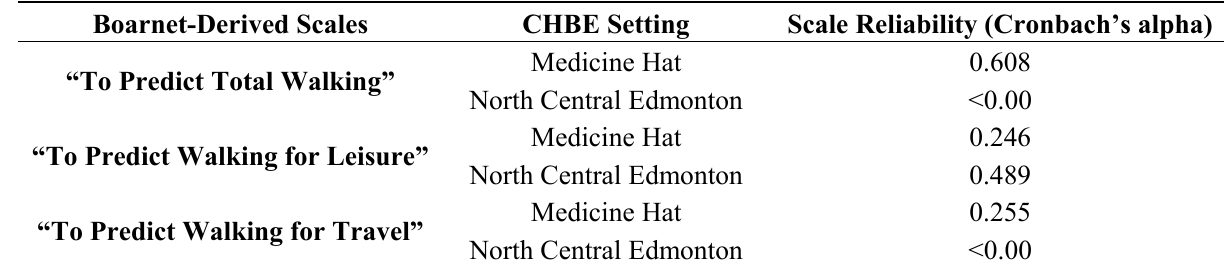
Table 3. Internal consistency of Boarnet et al .